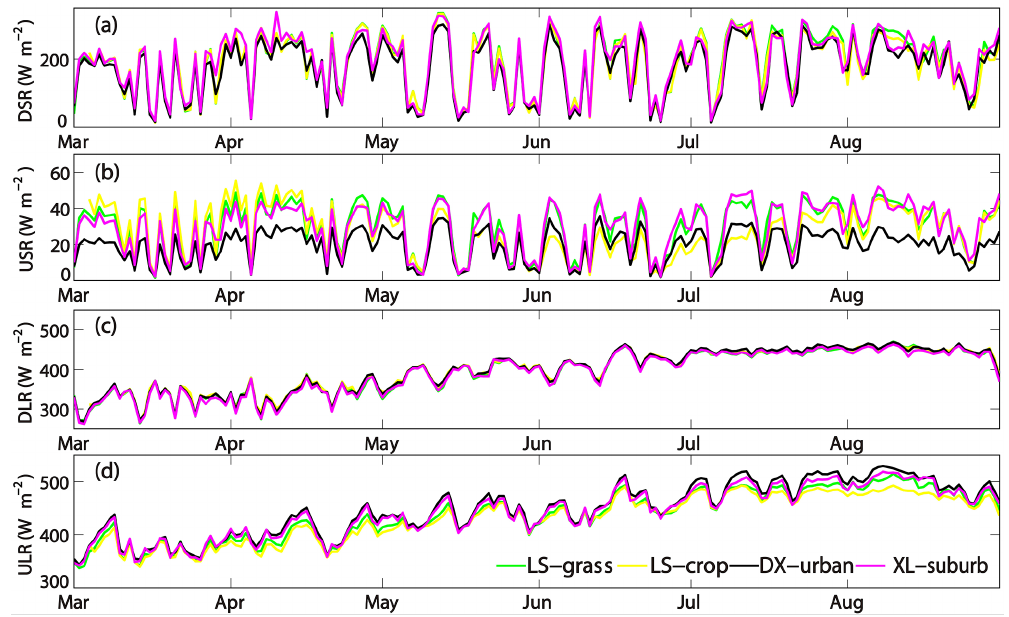
Figure 4. Daily variation in (a) downward shortwave radiation (DSR), (b) upward shortwave radiation (USR), (c) downward longwave radiation (DLR), and (d) upward longwave radiation (ULR) at the four sites in